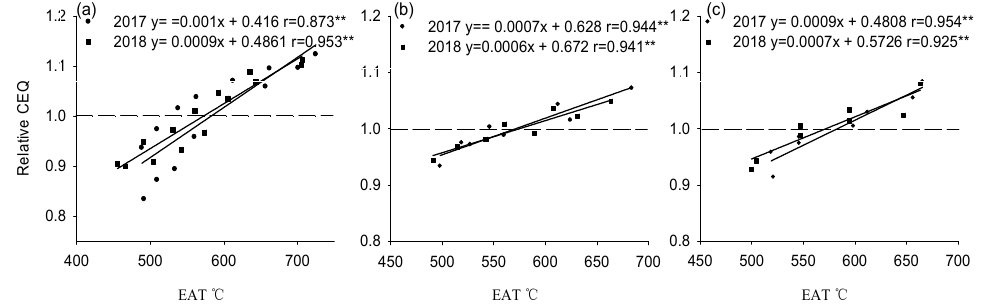
Figure 8. Correlation between relative CEQ and EAT at the stage from heading to maturity. ( a ): SMR, n = 14, ( b ): SLR n = 8, ( c ): LR, n = 8, (the immature treatment including T5, T6 and T7 were removed from SLR and LR). **, p < 0.01, respectively.